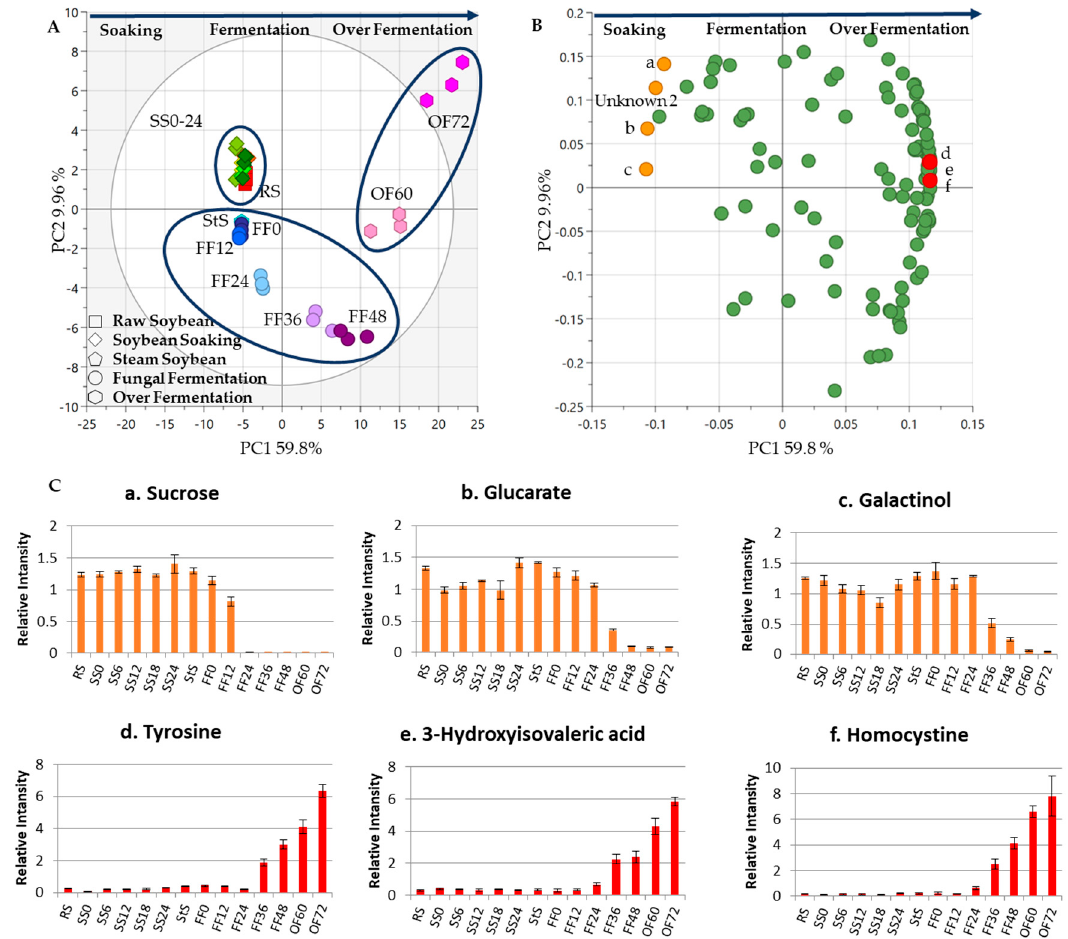
Figure 5. The PCA results of 14 soybean samples from different sampling times were obtained to observe the metabolite profiles from tempe production to over-fermentation. The metabolites changed along the process. ( A ) The score plot shows the separation between each sample based on sampling time. All soybean soaking, fungal fermentation, and over-fermented samples were clustered separately into three groups. The points indicate the treatment times, the different shapes from the legend represent different treatments (RS: raw soybean, SS: soaked soybean, StS: steamed soybean FF: fungal fermentation, OF: over-fermentation), and the numbers indicate different sampling times in hours (0 h, 6 h, 12 h, 18 h, 24 h, 36 h, 48 h, 60 h, and 72 h). ( B ) Loading plot. The metabolites are markers from the FF treatment and are lettered as follows: (a) sucrose; (b) glucarate; (c) galactinol; (d) tyrosine; (e) 3-hydroxyisovaleric acid; (f) homocysteine. ( C ) Bar charts. The metabolites shown on the bar chart are markers from the SS, FF, and OF processes. The vertical axis represents relative intensity. The horizontal axis represents the samples. The error bar shows the standard deviation obtained from three replicates.